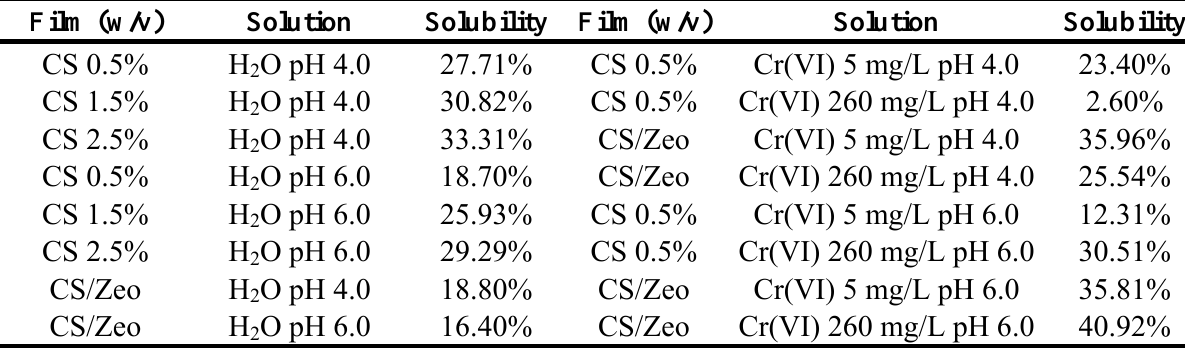
Table 1. Effect of chitosan concentration, presence and metal concentration and pH onto the chitosan (CS) and chitosan/zeolite (CS/Zeo 1:10 w/w) film